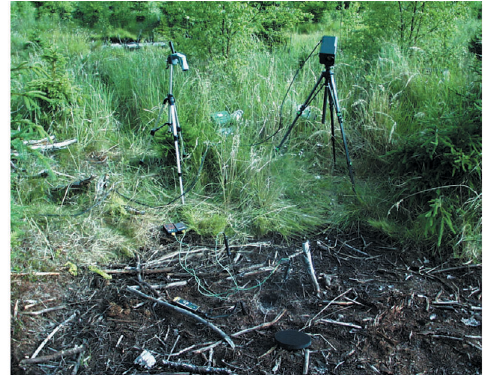
Fig. 12. Mofette location in forest of Podhorny Vrch, Czech